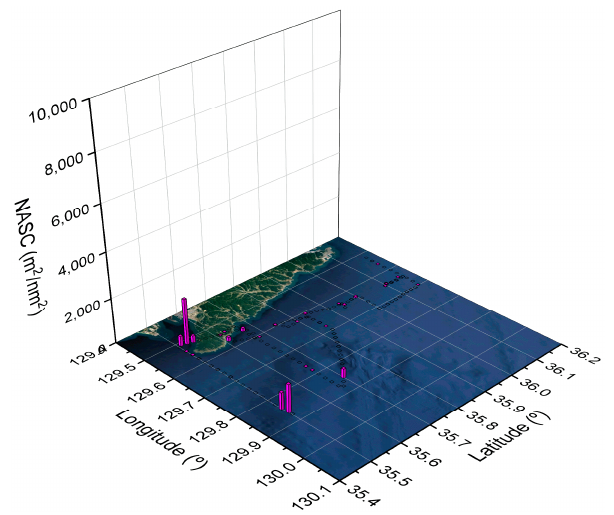
Figure 11. Spatiotemporal distribution of pacific cod.